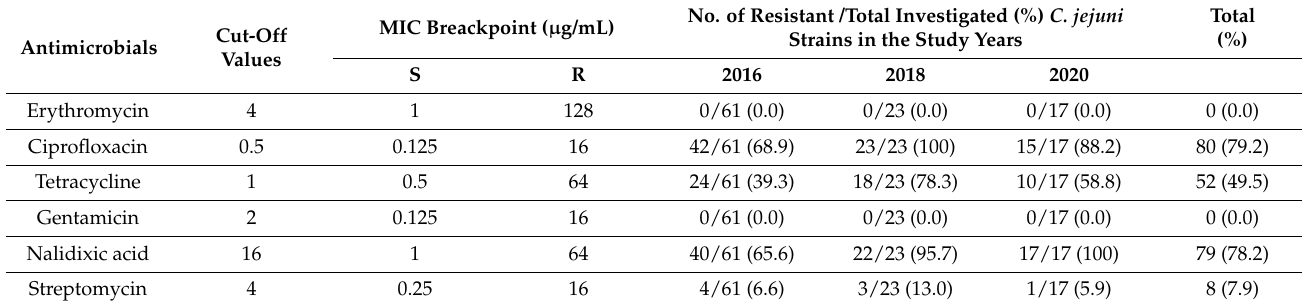
Table 2. Antimicrobial resistance of Campylobacter jejuni strains.